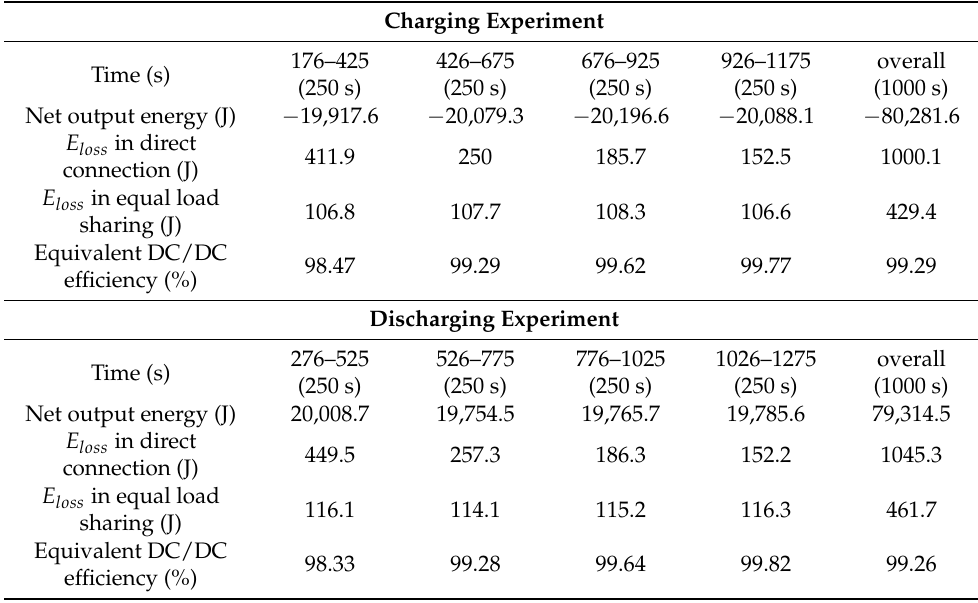
Table 2. Power loss in the charging and discharging